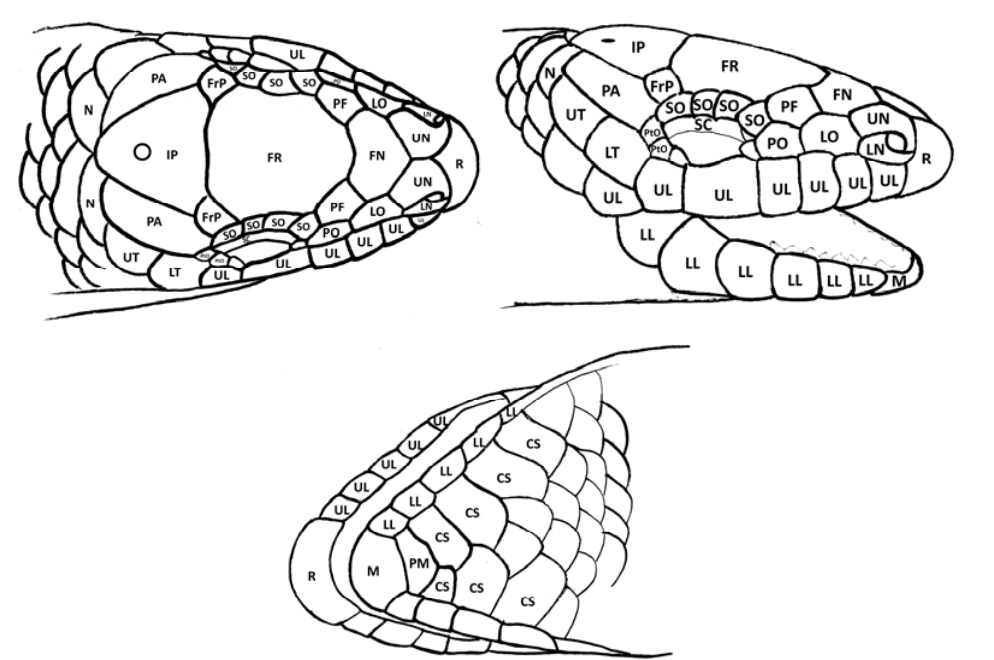
F IGURE 4. Head of Ophiomorus nuchalis (The specimen